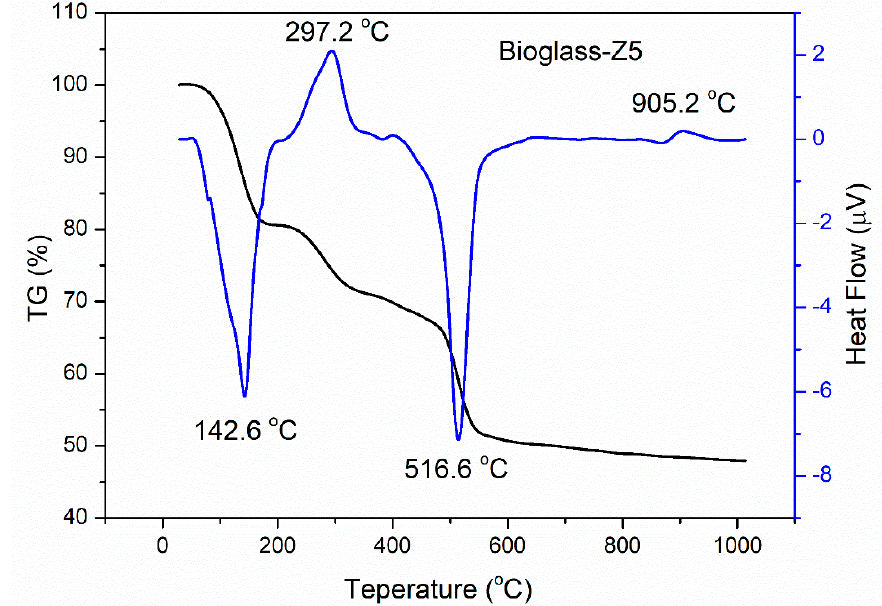
Figure 1. Thermogravimetry–differential scanning calorimetry ( TG-DSC) curves of bioactive glasses 70SiO 2 –(30-x)CaO–xZnO (mol.%, x = 1, 3,